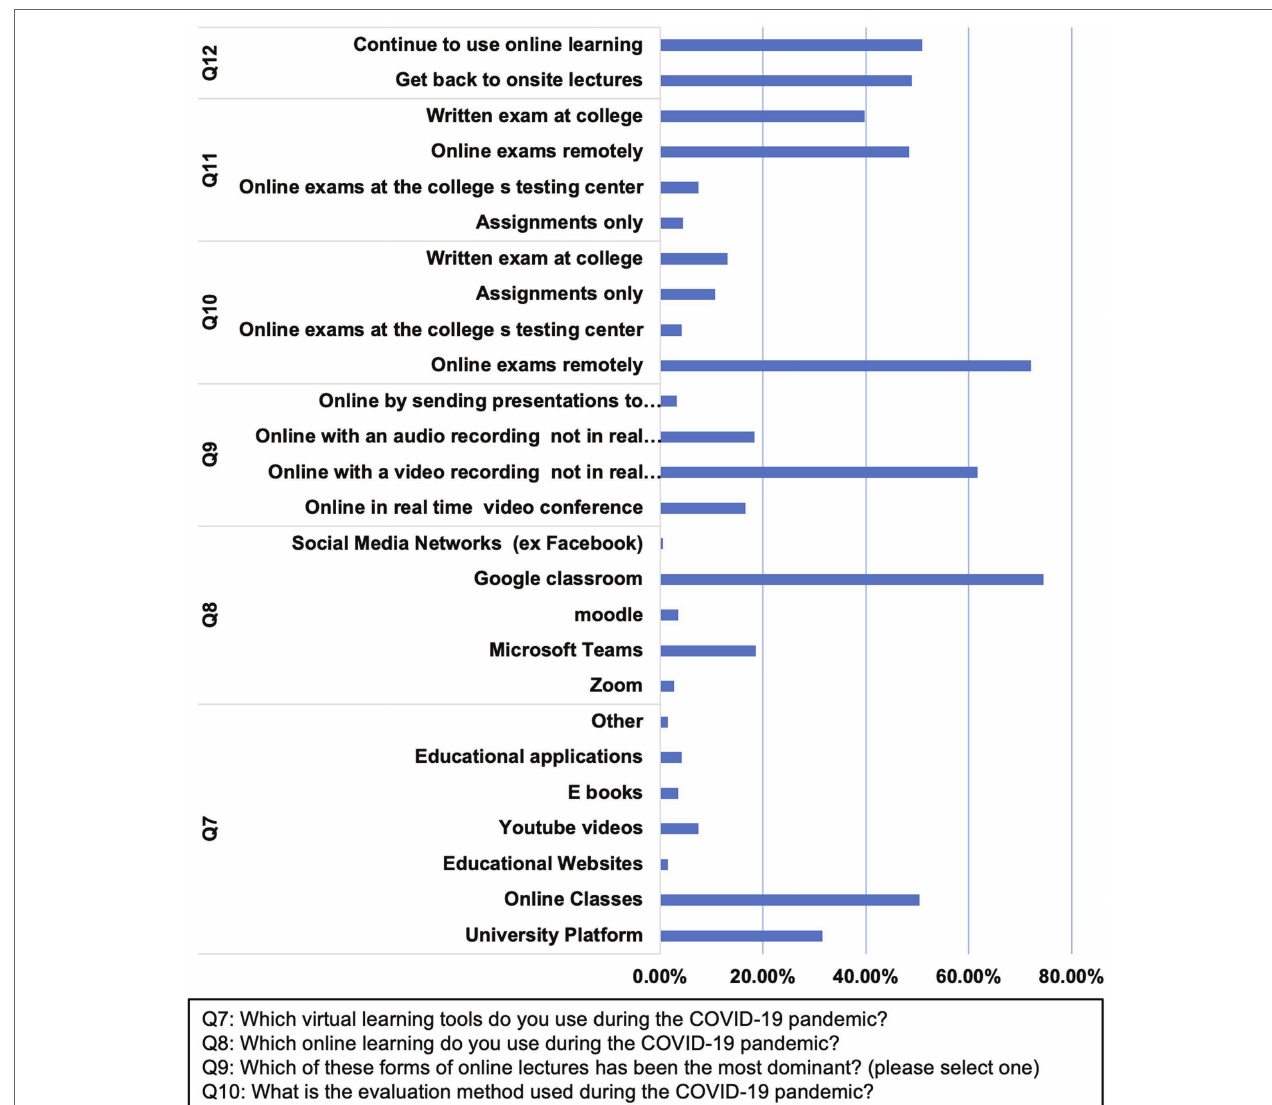
FIGURE 3 | Students’ responses to the survey on the impact of COVID-19 pandemic on the academic performance. The corresponding questions are as follows: Q7: Which virtual learning tools do you use during the COVID-19 pandemic? Q8: Which online learning do you use during the COVID-19 pandemic? Q9: Which of these forms of online lectures has been the most dominant? (Please select one) Q10: What is the evaluation method used during the COVID-19 pandemic? Q11: Which method of evaluation do you find most accurate and convenient? Q12: Would you prefer to get back to on-site lectures or continue to use online education after the end of the